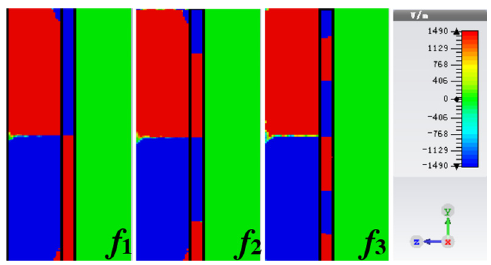
Fig. 4. Electric fi eld component E z at x = 0 corresponding to different absorption peaks when the phase is zero.